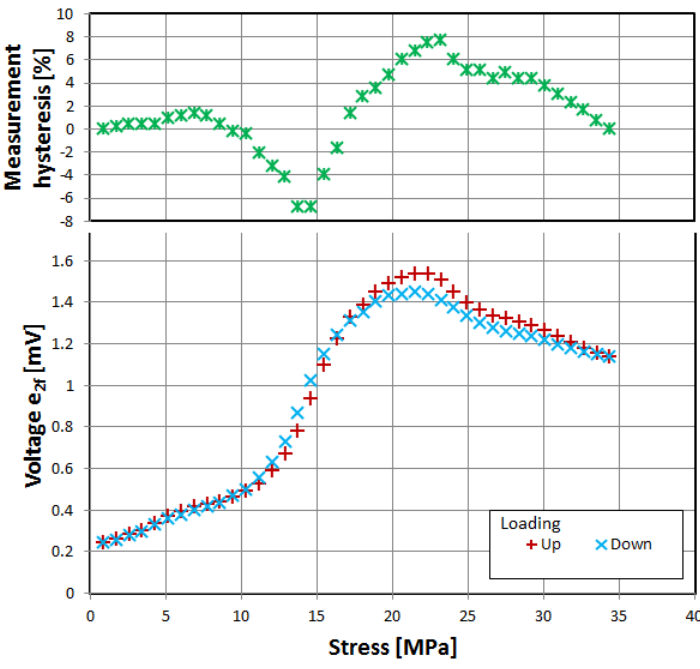
Figure 4. Dependence of induced e 2f voltage on tensile stress, alloy 6030D.